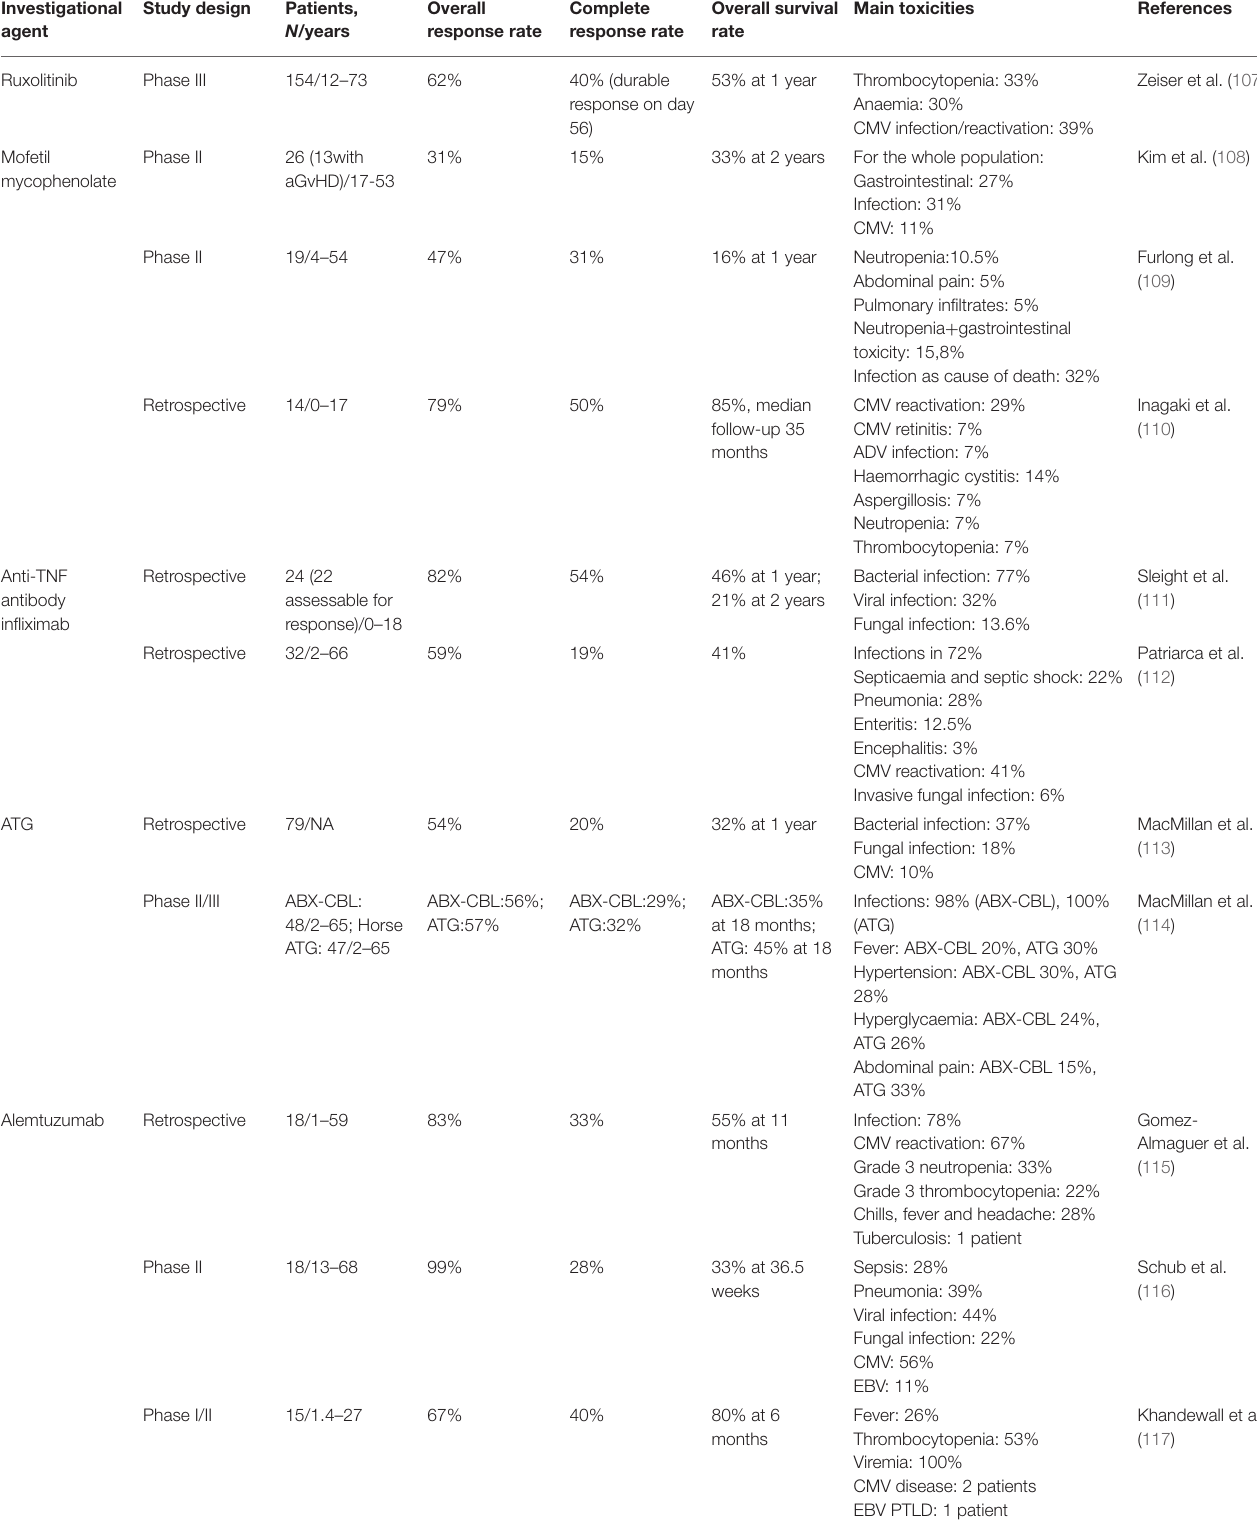
TABLE 5 | Studies of conventional pharmacological second-line treatments for steroid-refractory aGvHD that included children. Investigational